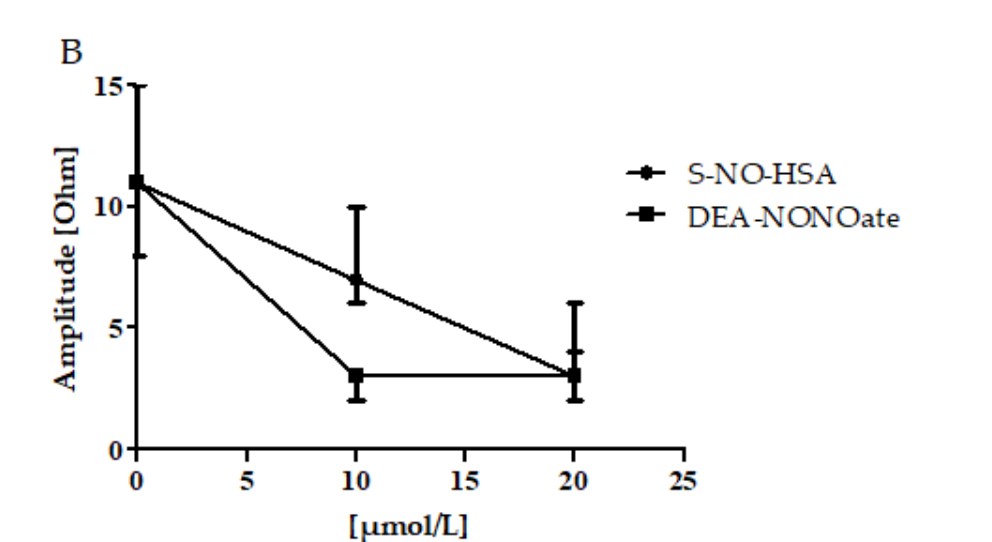
Figure 4. Effects of increasing concentrations of S-NO-HSA or DEA-NONOate on nitrite levels and on impedance aggregometry amplitudes in PRP. Panel ( A ): Nitrite levels dose-dependently increased in the presence of increasing concentrations of S-NO-HSA ( n = 6). At 20 µ mol/L DEA-NONOate, nitrite levels were 21.59 (16.51–32.75) µ mol/L ( p < 0.001 vs. physiological sodium chloride; data not illustrated in the figure). ANOVA and Bonferroni post-test were used to evaluate differences in plasma nitrite levels. The results are presented as median with range. * p ≤ 0.05; ** p ≤ 0.01; *** p ≤ 0.001. Panel ( B ): Both S-NO-HSA ( n = 17) and DEA-NONOate ( n = 8) efficiently inhibited platelet aggregation. Virtually no platelet aggregation occurred in the presence of 20 µmol/L S-NO-HSA and 10 µmol/L DEA-NONOate ( n = 8), respectively. The results are presented as mean ± SD. The data at 0 µmol/L represent the values of the appropriate controls (no NO-donor added).